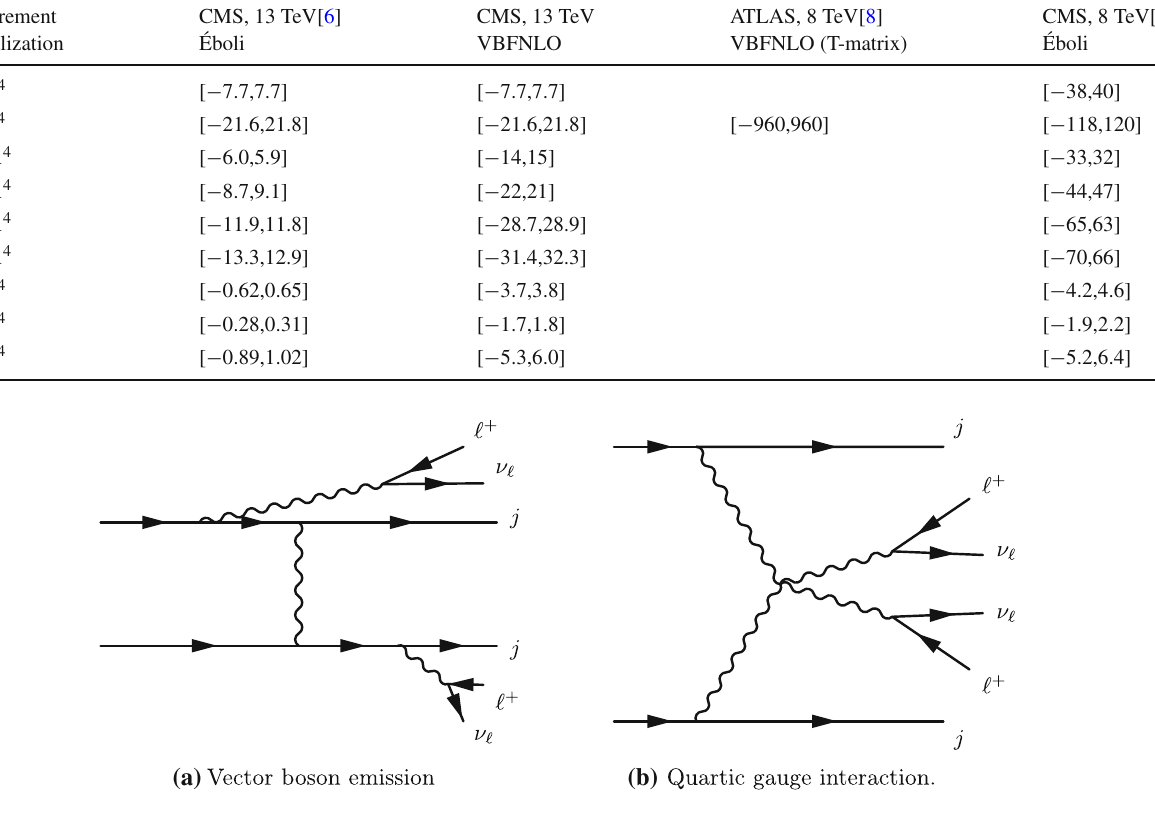
Fig. 3 Examples of Feynman graphs contributing to vector boson scattering contracted with quark currents, J emission of a virtual vector boson, V , off an initial parton in Fig. 3b. This structure is well suited to implement the BSM amplitude